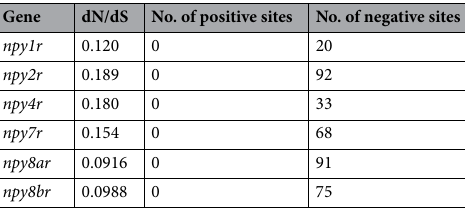
Gene dN/dS No. of positive sites No. of negative